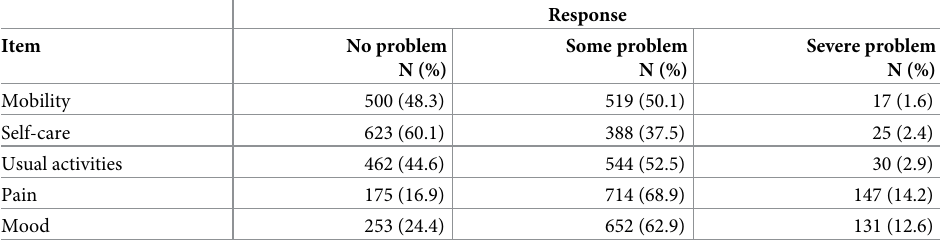
Table 2. Distribution of responses for the descriptive question of the EQ-5D-3L.